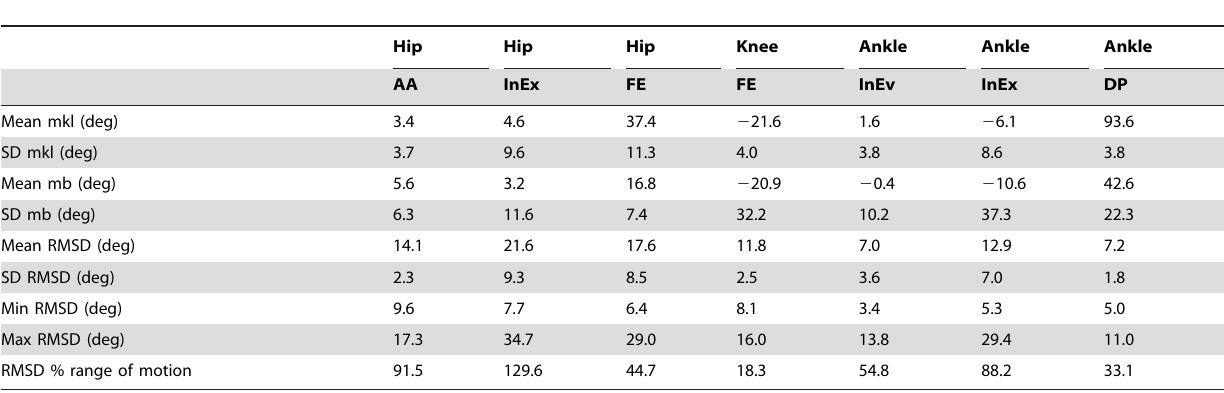
Table 1. Description of root mean square distance (RMSD) values between angles calculated with the two techniques (markerless (mkl) and marker-based (mb)); mean, standard deviation (SD), minimum (Min) and maximum (Max) RMSD values are